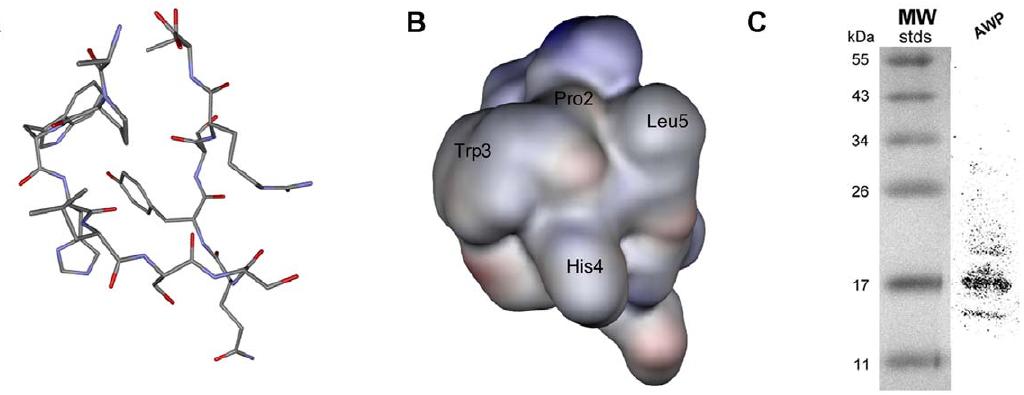
Figure 5. Molecular dynamics simulated structure of APWHLSSQYSRT peptide. (A) Stick model showing the scheme of folding with hydrogen hidden. (B) Surface model showing the possible binding site and selected side chains (Proline 2, Tryptophan 3, Histidine 4 and Leucine 5). (C) Western blotting result of APW phage binding to ES cell proteins. A major band was detected at 17 kDa and a minor band was detected at around 15 kDa. cells aggregate and form simple EB. After day 4, the EB form basal lamina (smoothen edge) and a central cavity occurs. Table S1 Homological sequences identified by protein database search.